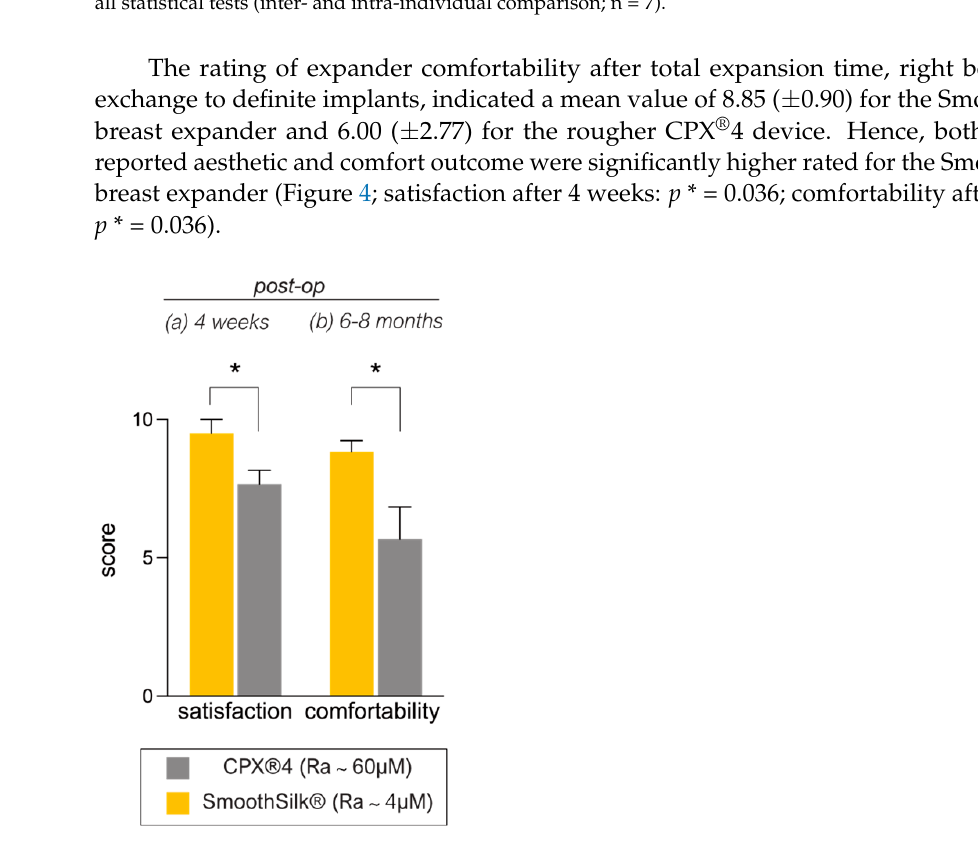
Figure 4. Patient ( a ) satisfaction and ( b ) comfortability rating of tissue expanders 4 weeks ( a ) and 6–8 months ( b ) post-op (satisfaction: p * = 0.036; comfortability: * p = 0.036; n = 7). Mean values ± SD of seven biological replicates (patients) are shown. The level for statistical significance was set at p ns > 0.05, * p < 0.05, ** p < 0.002, *** p < 0.0002, and **** p < 0.0001, for all statistical tests. (inter- and intra-individual comparison; n =